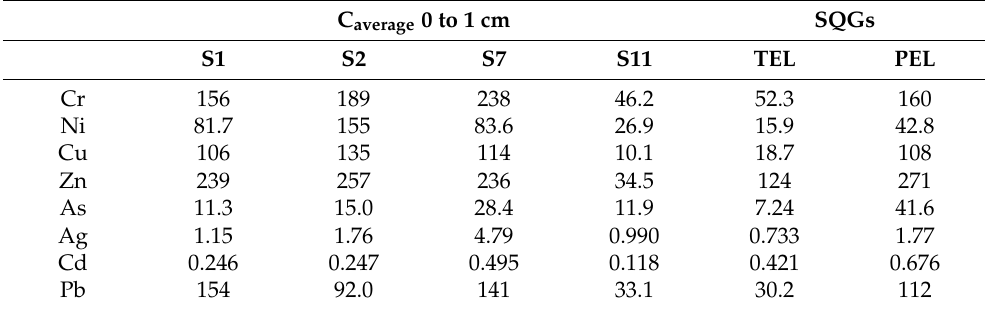
Table 4. TEL and PEL levels and average metal concentrations (mg · kg − 1 ) in the surface sediments (0 to 1 cm in depth) of the Inner Saronikos and Elefsis Bay stations ( n = 2 for each station).